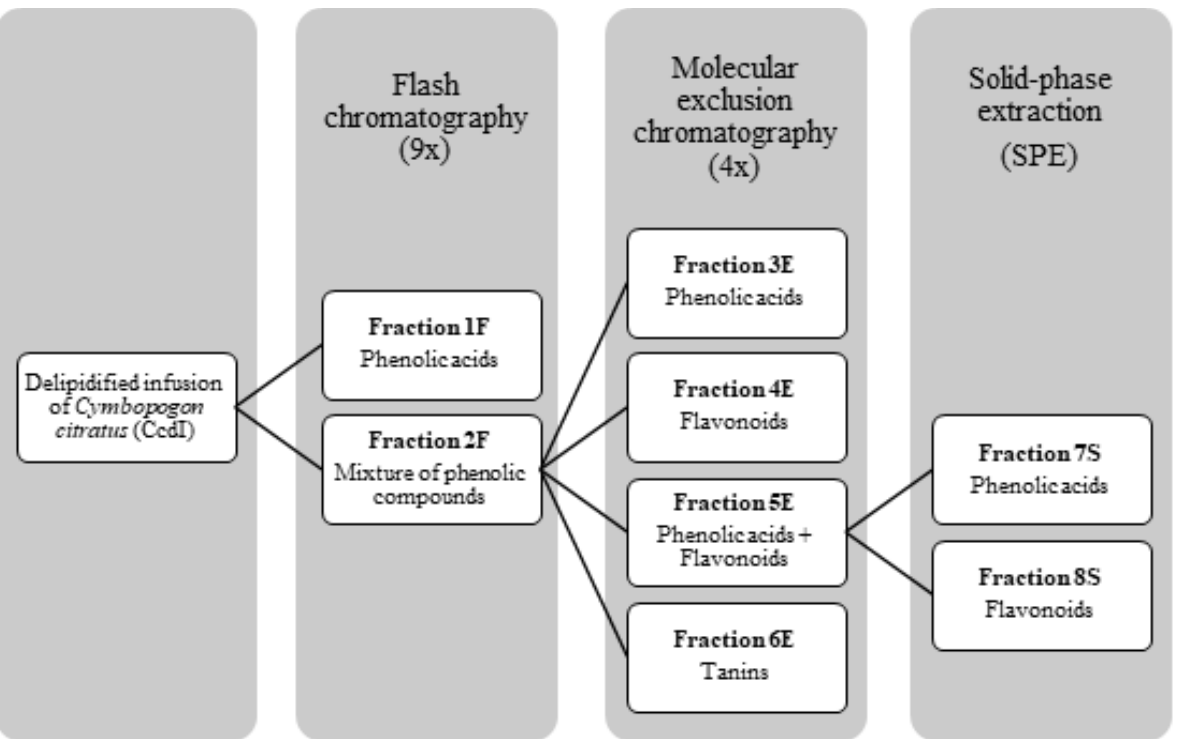
Figure 9. Fractionation process of phenolic compounds present in the delipidified infusion (CcdI) of the Cymbopogon citratus leaf.